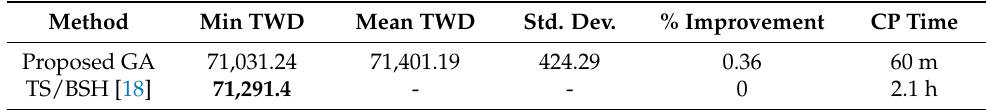
Table 6. Summary of results for test problem